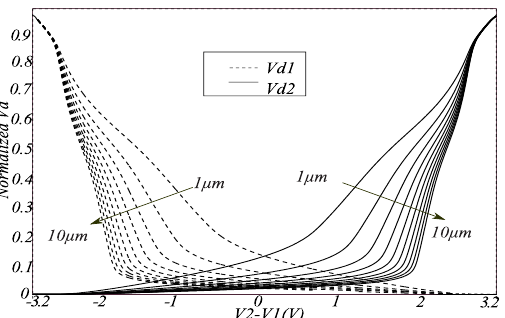
Figure 3. Simulation of currents I 1 and I 2 when the widths of the transistors M 1 and M 2 are increased from 1 µ m to 10 µ m simultaneously with a common-mode voltage of Vdd /2. The curves are normalized for the maximum value of the currents in the legs. The dashed curves are the sum of the normalized currents which has a bell shape.